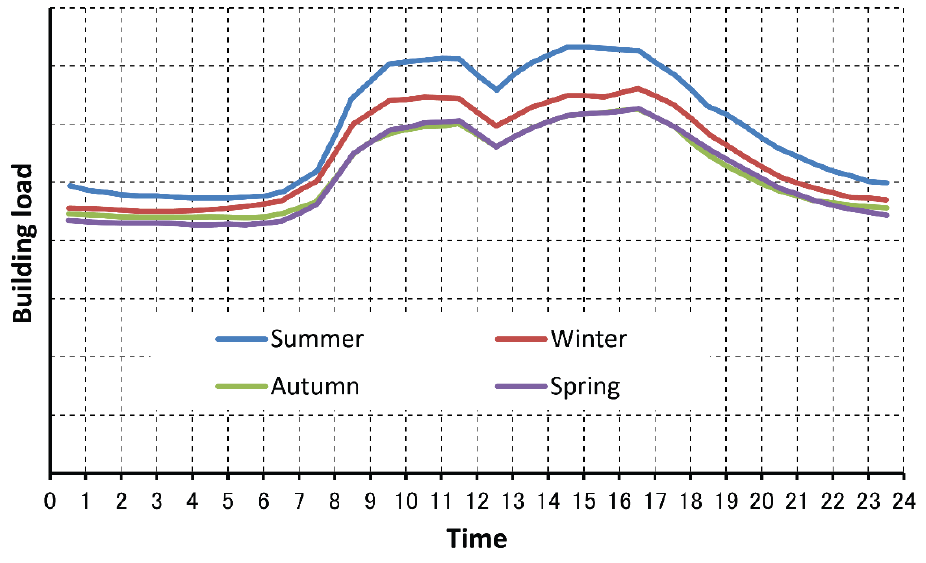
Figure 4. Seasonal average load for office